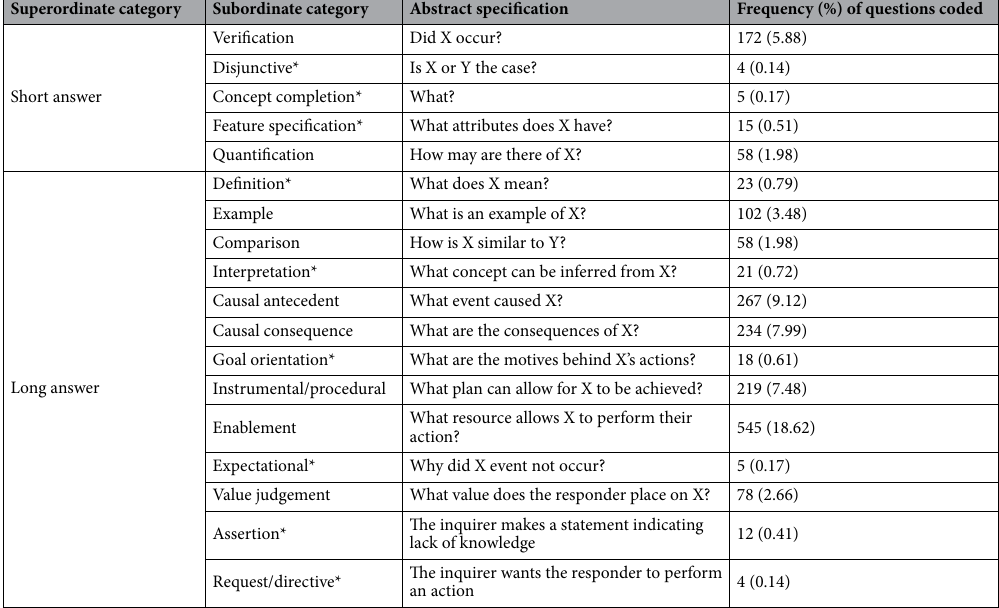
Table 2. Frequency (%) of questions per style category (* indicates categories that were omitted in the development of the revised taxonomy). This table shows the frequency of the questions coded into each question style category when using the Taxonomy of Question Styles. It also shows the categories omitted from the Revised Taxonomy of Question